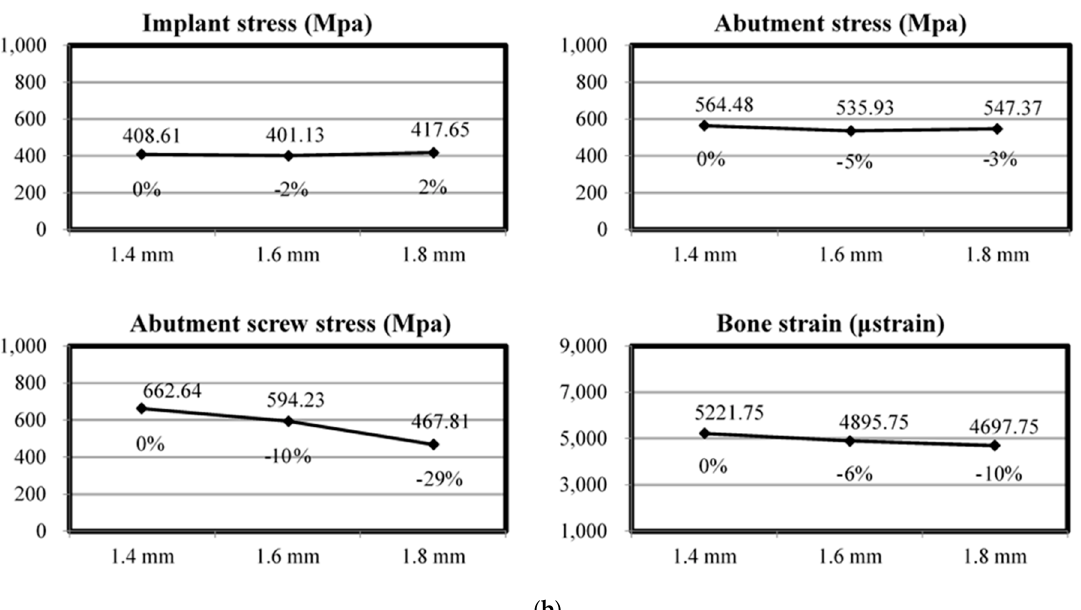
Figure 2. Main e ff ect plots of implant neck wall ( a ) and abutment screw size at each level for maximum Figure 2. Main effect plots of implant neck wall ( a ) and abutment screw size at each level for implant, abutment, and abutment screw stresses and maximum bone strain ( b ). Appl. Sci. 2020 , 10 , x FOR PEER REVIEW maximum implant, abutment, and abutment screw stresses and maximum bone strain ( b ).